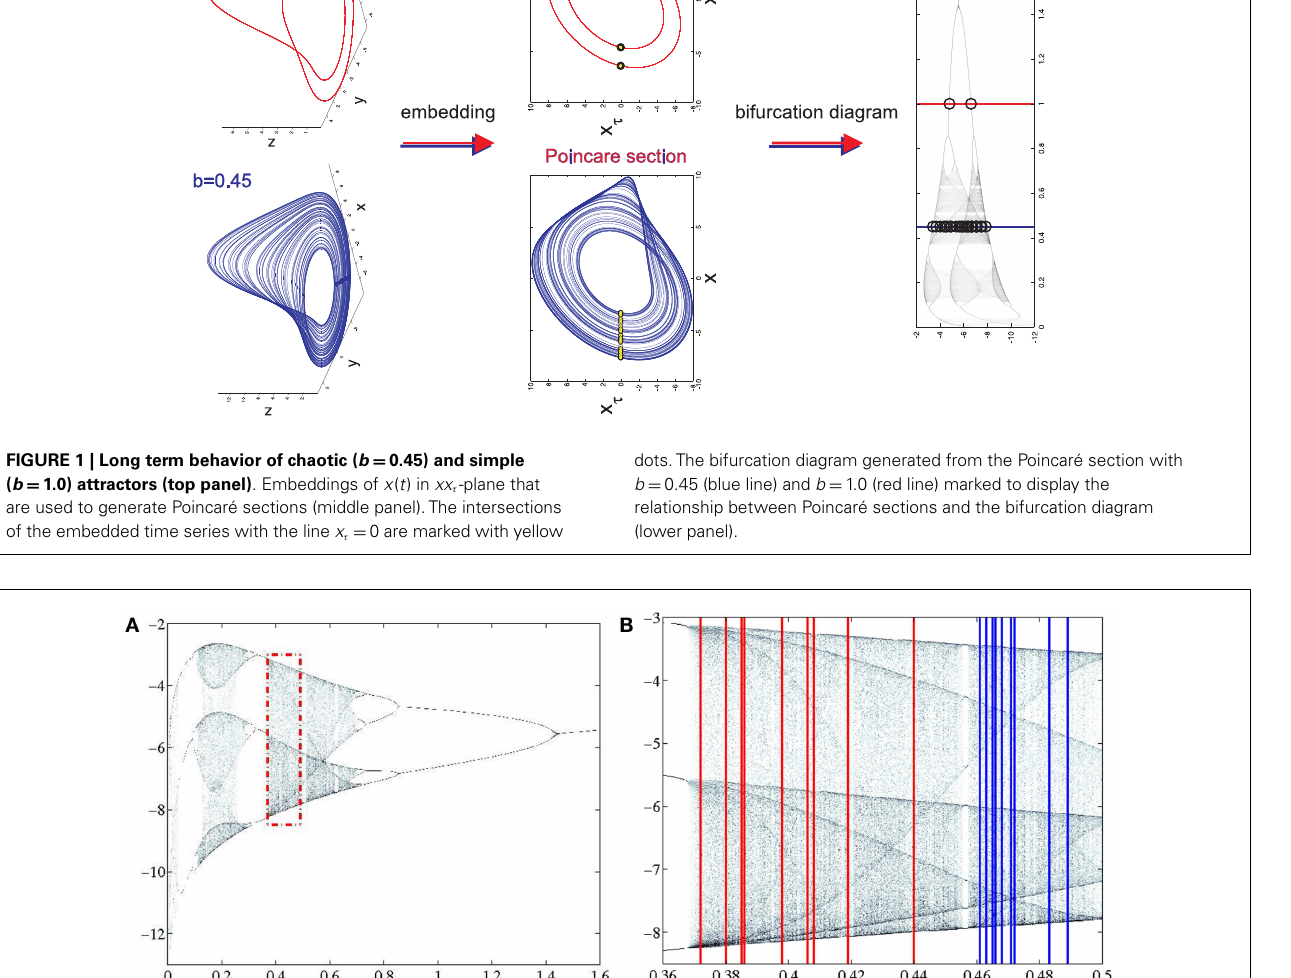
FIGURE 2 | (A) Section of the bifurcation diagram from which the bifurcation parameters for all subjects were selected is outlined in red. (B) Enlarged view of bifurcation range with PD and CO ranges clearly separated. PD subjects range 0.37–0.44 and are shown in red. CO subjects range 0.46–0.49 and are shown in